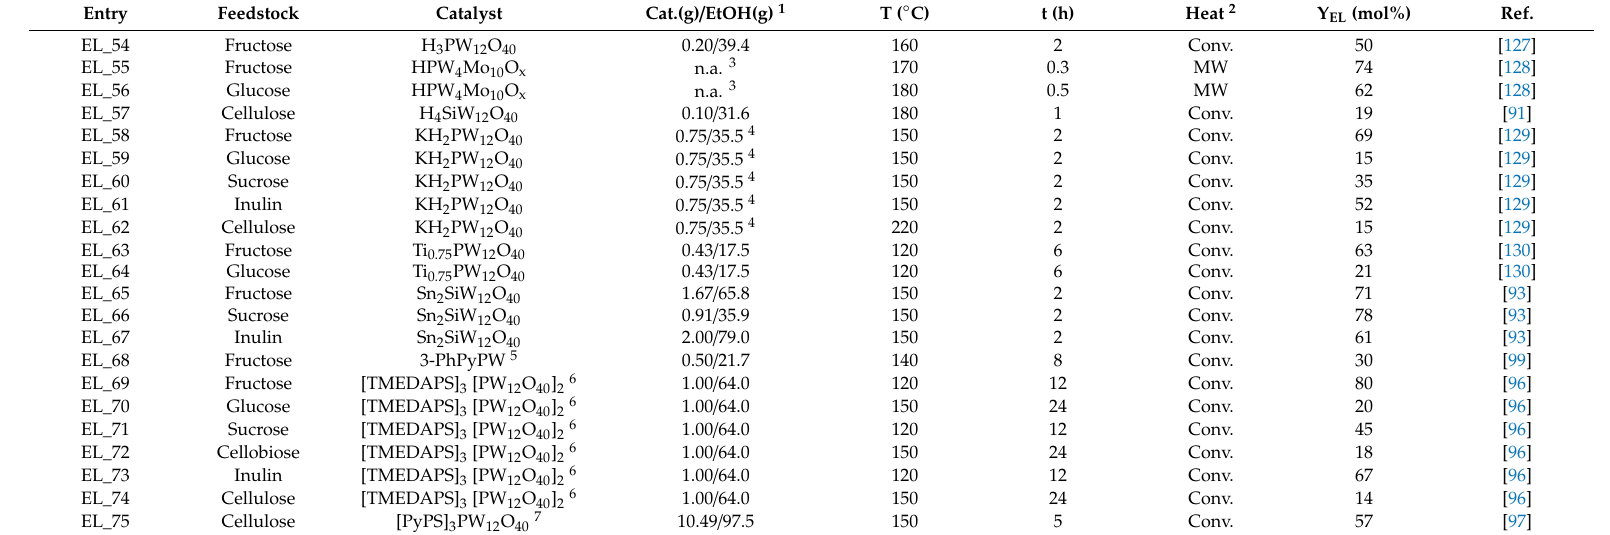
Table 9. Polyoxometalate (POM)-based catalysts for the EL production from C6 model